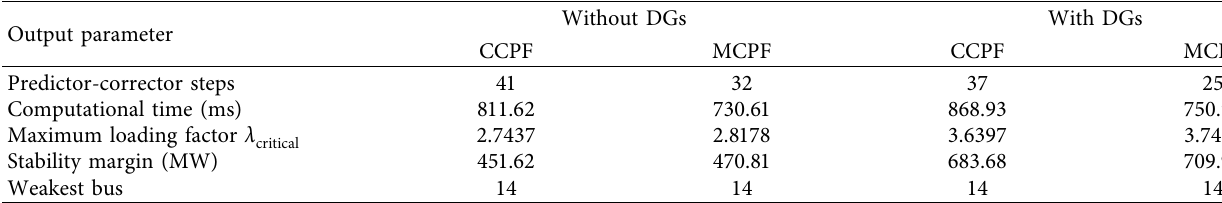
Figure 4: The P-V curve at bus 14 during the load-increasing process: (a) without DG; (b) with DG. Table 2: Comparisons between CCPF and MCPF of the IEEE 14-bus test